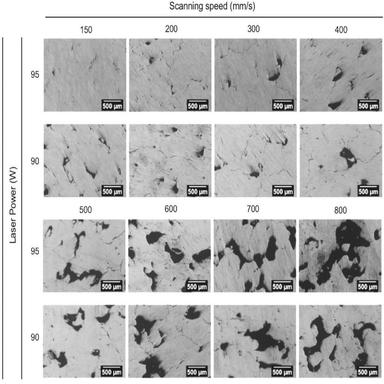
(a) Optical micrographs of Al-14Zn-3Mg at different laser power and scan speed, showing variation in porosity (minimum average porosity of 0.51% was obtained at a laser power of 95 W and scan speed of 150 mm/s).